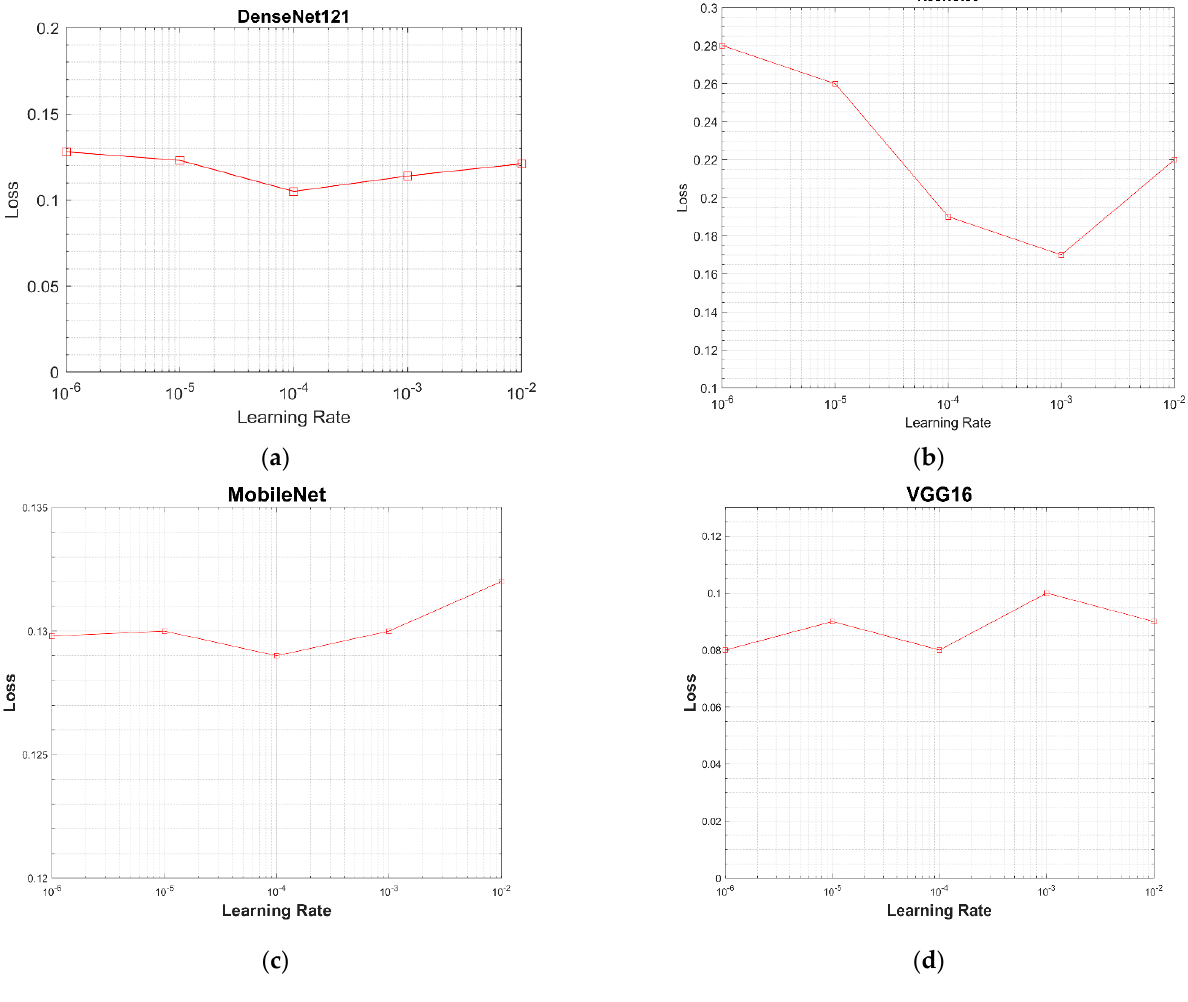
Figure 12. Graphs between testing loss and learning rate for all models: ( a ) loss vs. learning rate graph of DenseNet-121; ( b ) loss vs. learning rate graph of ResNet-50; ( c ) loss vs. learning rate graph of MobileNet; ( d ) loss vs. learning rate graph of VGG16.